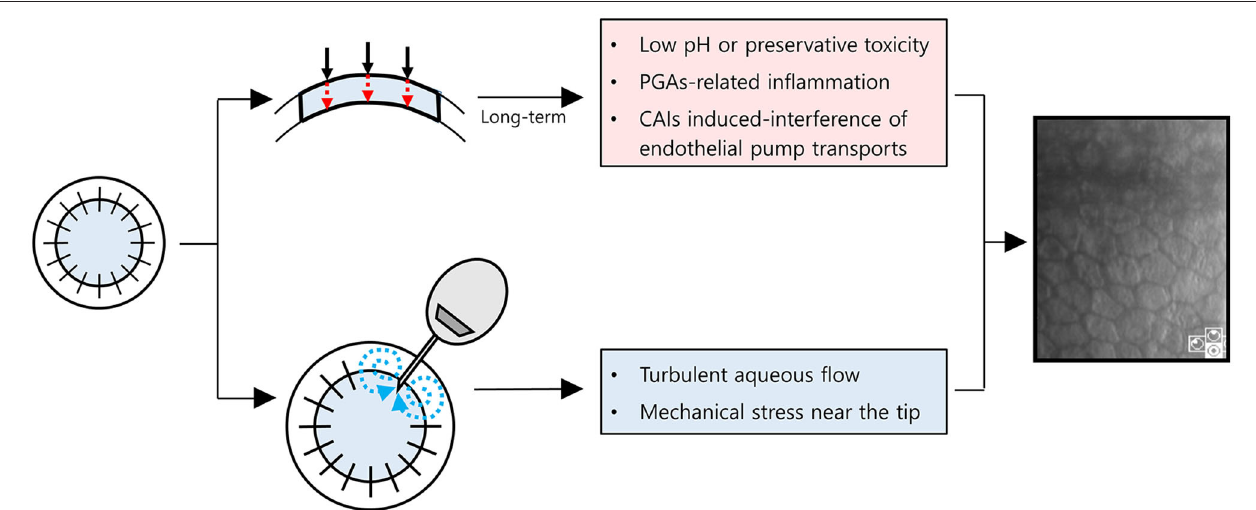
FIGURE 6 | Schematic diagram for a hypothesis on how to damage corneal endothelial cells with maximum tolerated medical therapy or glaucoma drainage device. Red dot arrows indicate anti-glaucoma eyedrops are permeable to endothelial cells with (1) low pH or preservative toxicity, (2) PGAs-related inflammation, or (3) CAIs induced-interference of endothelial pump transports. Blue dot arrows indicate turbulent aqueous flow near the tube. PGAs, prostaglandin analogs; CAIs, Carbonic anhydrase